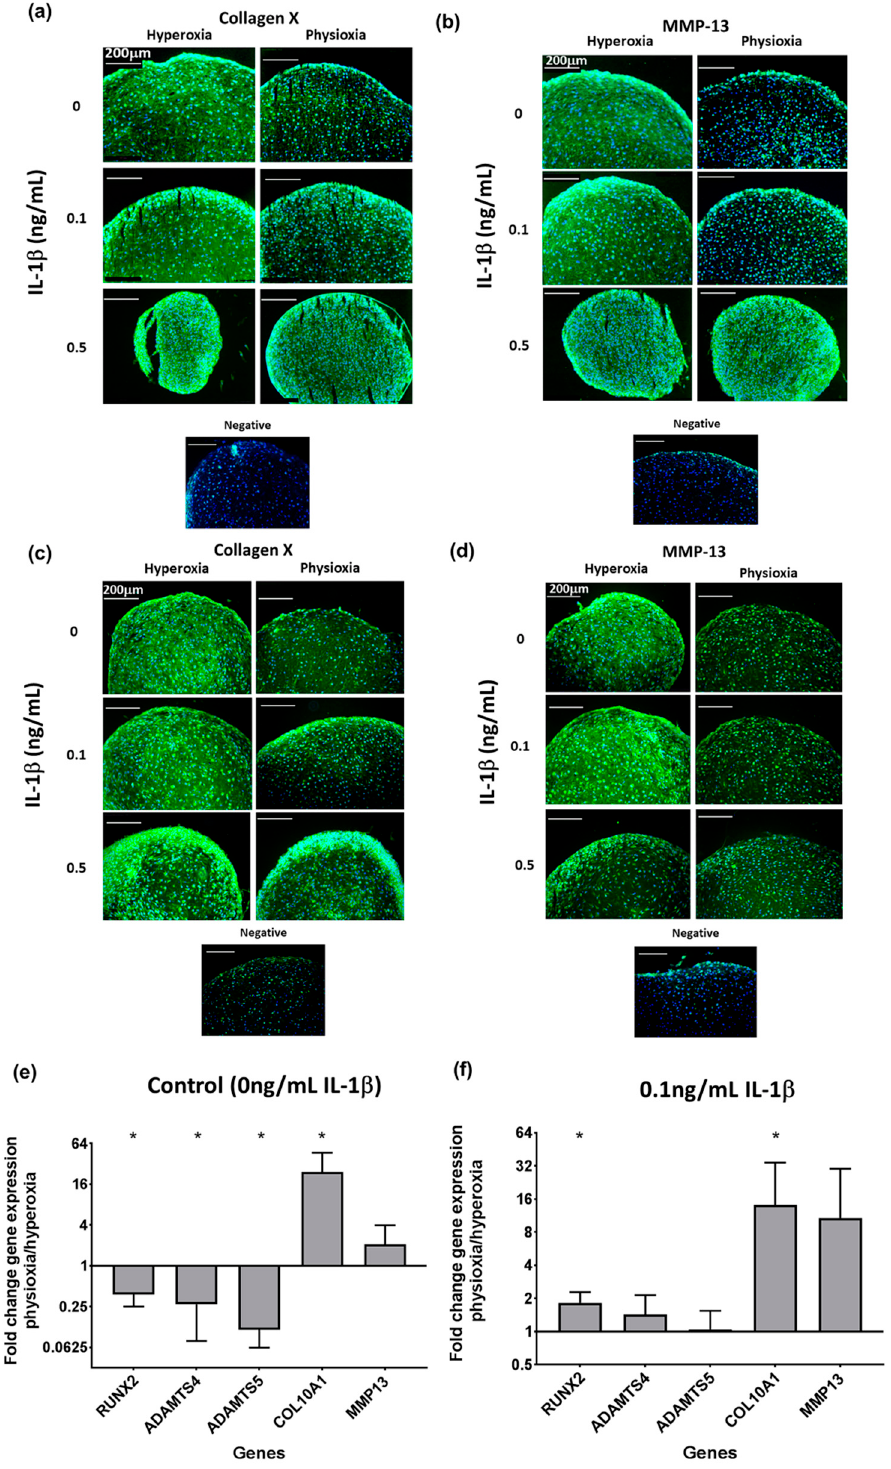
Figure 6. Representative images of chondrogenic pellet stained for ( a , c ) collagen X and ( b , d ) MMP-13 in physioxia ( a , b ) non-responsive and ( c , d ) responsive donors at control, 0.1 ng / mL or 0.5 ng / mL IL-1 β . Gene expression of ( e , f ) hypertophic genes under physioxia for ( e ) control and in the presence of ( f ) 0.1 ng / mL IL-1 β for physioxia responsive donors. Data represent the fold change in the expression of pellets cultured under ( a ) 0 ng / mL and ( b ) 0.1 ng / mL IL-1 β physioxia relative to the corresponding hyperoxic condition. Data represent mean ± S.D. of n = 4 physioxia responsive donors; * p < 0.05.